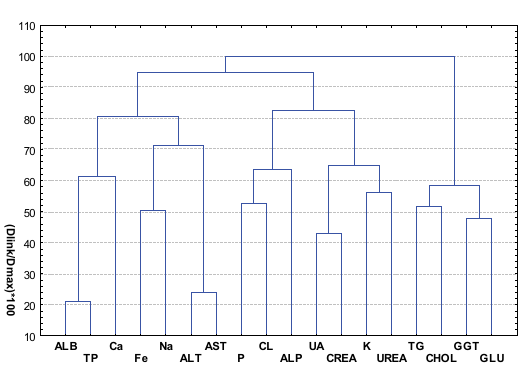
Figure 3. Hierarchical dendrogram of biochemical variables for female healthy individuals.